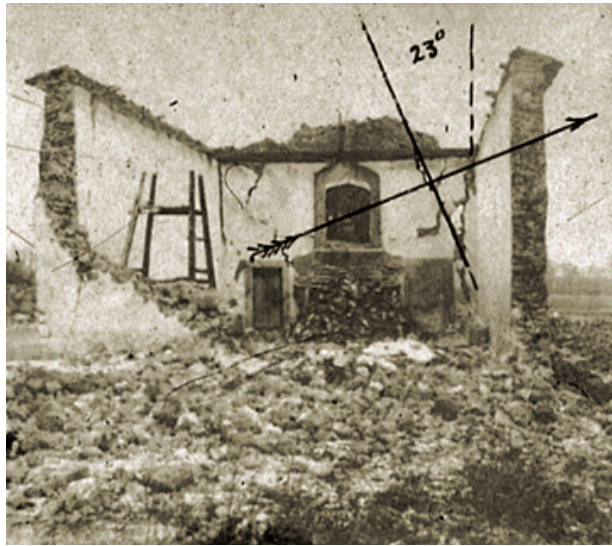
Figure 3. Church of the Trinity at Trinità di Sala Consilina (province of Salerno). Left photogram of one of the stereoscopic photos commissioned by Mallet. The pen lines superimposed by the Irish engineer contribute to the attribution of the photograph to Claude